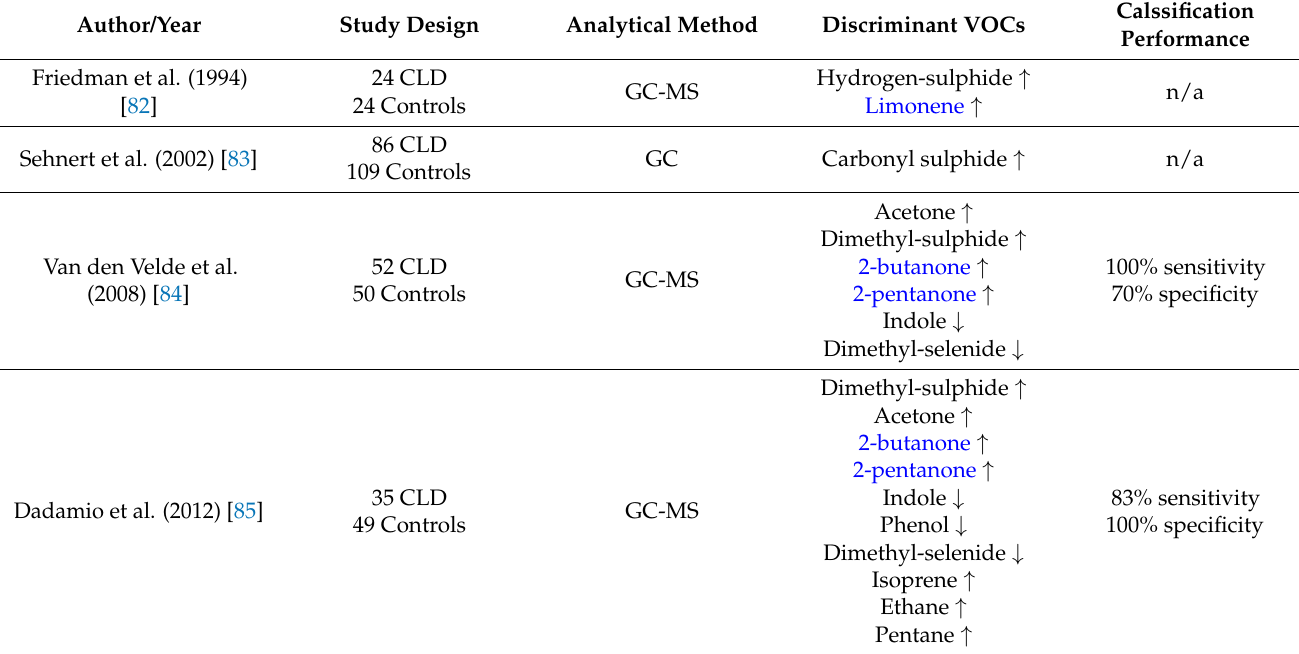
Table 1. Summary of studies that compared the breath of subjects with chronic liver diseases, against controls. Compounds in bold and blue are of exogenous origin. Arrows indicate if a compound is elevated or reduced in the breath of disease subjects compared to controls. CLD = chronic liver